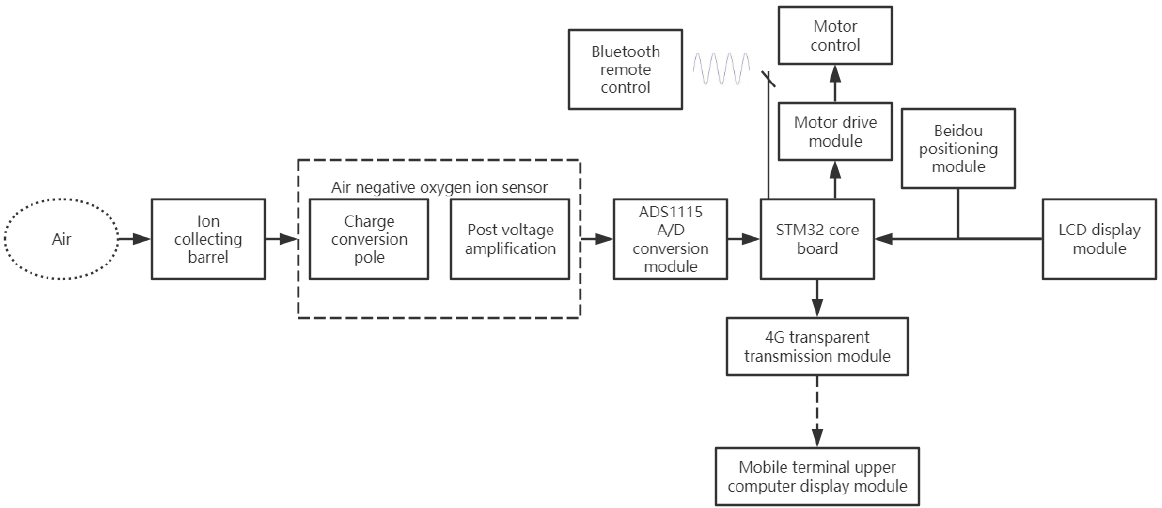
Figure 1. The overall design framework of the system. The composition and functions of each software and hardware component are shown in Table 1. The accuracy of each sensor is shown in Table